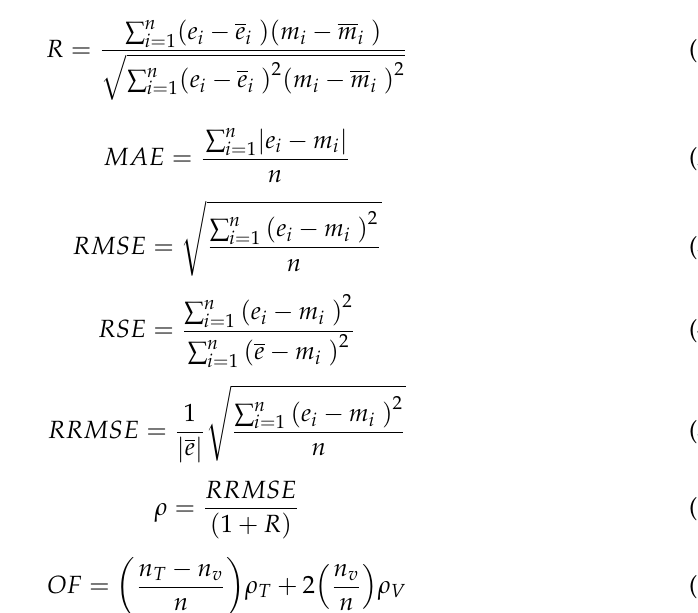
Figure 6. Effect of number of genes on statistical evaluation of the developed GEP models. As previously mentioned, the GEP algorithm was allowed to randomly partition the training and validation data. By doing so, the models generated during the training process tend to overfit, enhancing the performance of the training set while decreasing the validation data performance [44]. To avoid this issue, Gandomi et al. [45] suggested selecting a model with the minimum objective function (OF) expressed as Equation (7). The magnitude of the OF ranges from 0 to the maximum, whereas a value approaching zero implies a relatively better model [46]. The value of R ranges between 0 and 1, where 1 reflects a perfect correlation, whereas a value of zero shows no correlation between the inputs and the target variable. It has also been reported that R exceeding 0.8 represents a more robust prediction of the forecasted values [47]